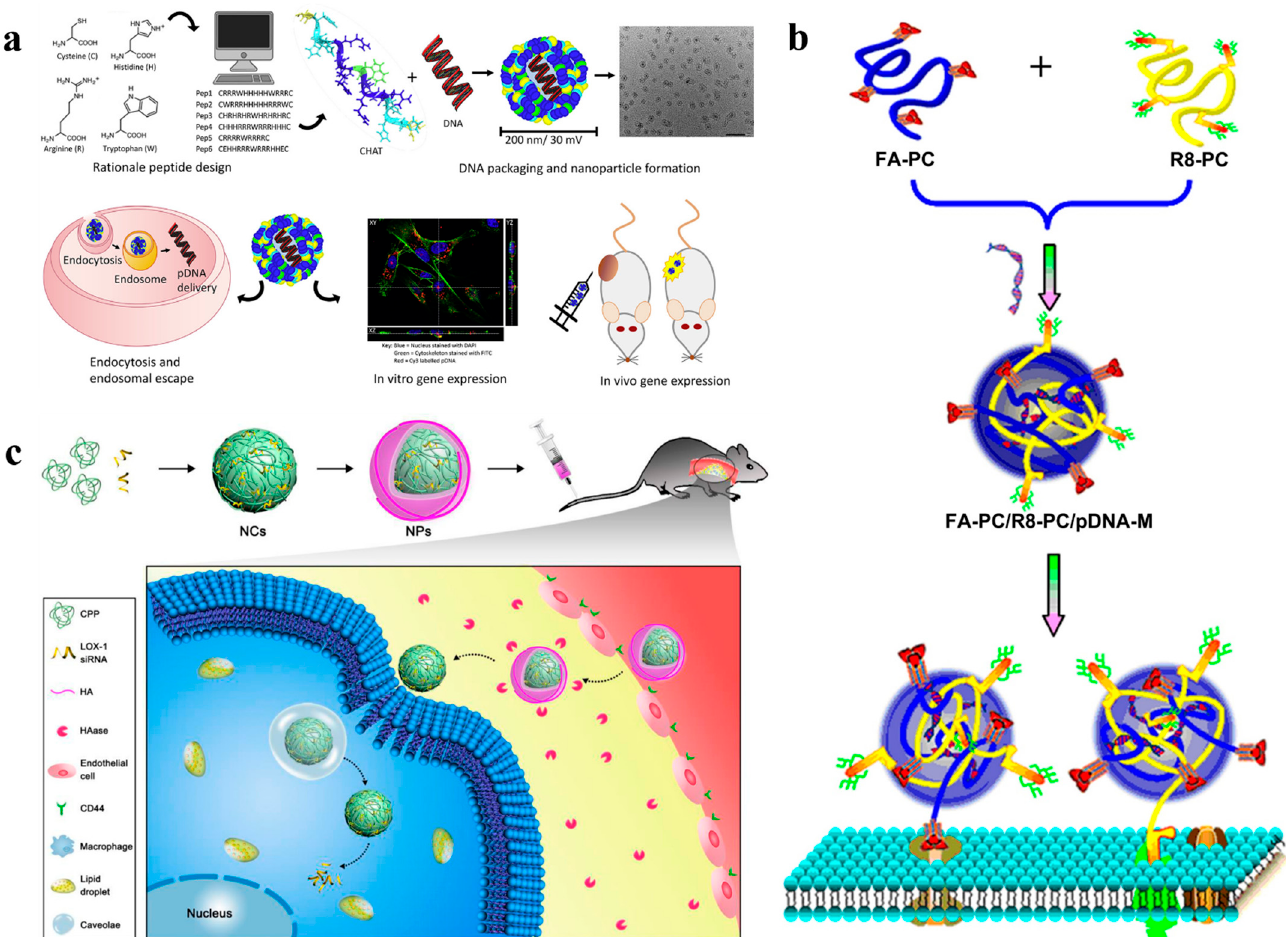
Figure 3. ( a ) CHAT peptide condenses pDNA to produce cationic nanoparticles less than 200 nm in diameter. The complex can cross the cell membrane through endocytosis and successfully escape from the endosomes, obtaining high transfection efficiency. Reprinted with permission from Ref.